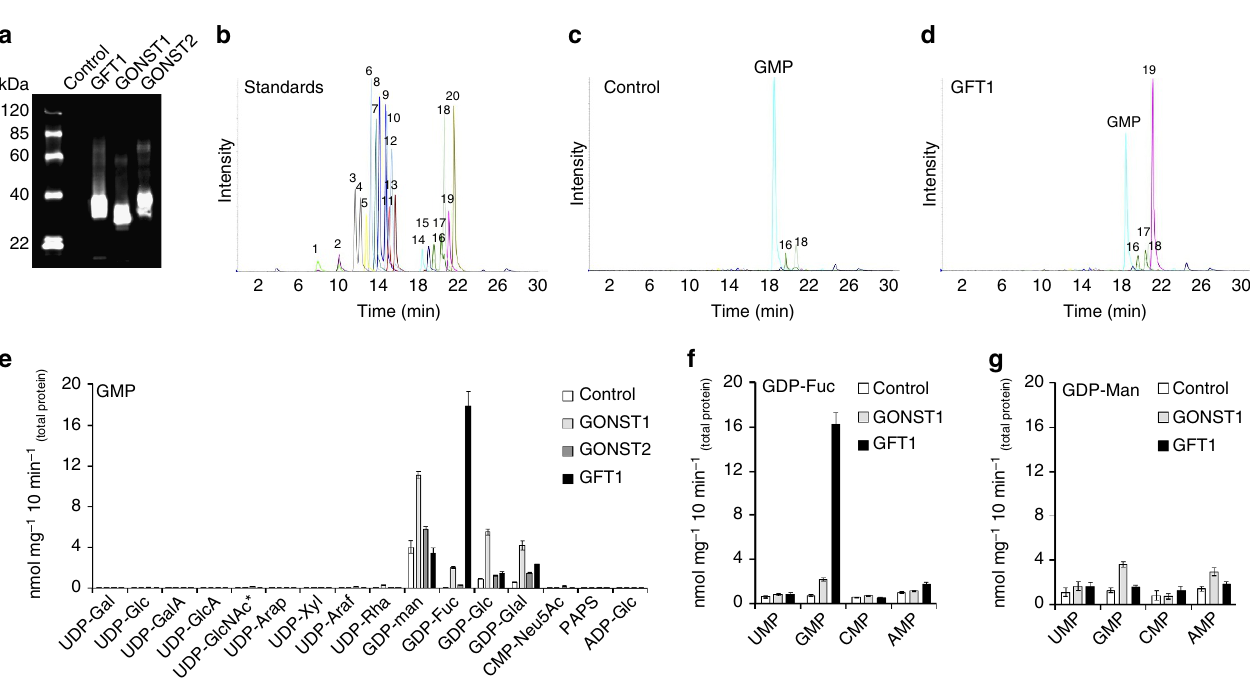
Figure 3 | LC-MS/MS analysis of nucleotide sugar transport activities for GFT1 and other GONST members. ( a ) Immunoblot analysis of empty vector, GFT1, GONST1 and GONST2 expression in proteo-liposomes (2.5 m g protein per lane). ( b ) Separation of a 20 nucleotide/nucleotide sugar mix (1, CMP; 2, UMP; 3, UDP-GalA; 4, UDP-GlcA; 5, CMP-Sia; 6, UDP-Ara p ; 7, UDP-Rha; 8, UDP-Gal; 9, UDP-Glc; 10, UDP-Xyl; 11, UDP-GlcNAc/GalNAc; 12, UDP-Ara f ; 13, PAPS; 14, GMP; 15, AMP; 16, GDP-Man; 17, GDP-Gal; 18, GDP-Glc, 19, GDP-Fuc; 20, ADP-Glc). LC-MS/MS analysis of proteo-liposomes derived from ( c ) yeast transformed with the empty vector (control) or ( d ) yeast expressing GFT1 after simultaneous incubation with 16 nucleotide sugar substrates. ( e ) Quantification of nucleotide sugar transport into proteo-liposomes pre-loaded with 10mM GMP. ( f and g ) Exchange substrate specificities of GFT1 and GONST1. Proteo-liposomes were loaded with 1mM GDP-Fuc ( f ) or 1mM GDP-Man ( g ) and incubated with a mix of UMP, GMP, CMP, AMP at a concentration of 200 m M. Data are mean and s.d. of n ¼ 4 assays.